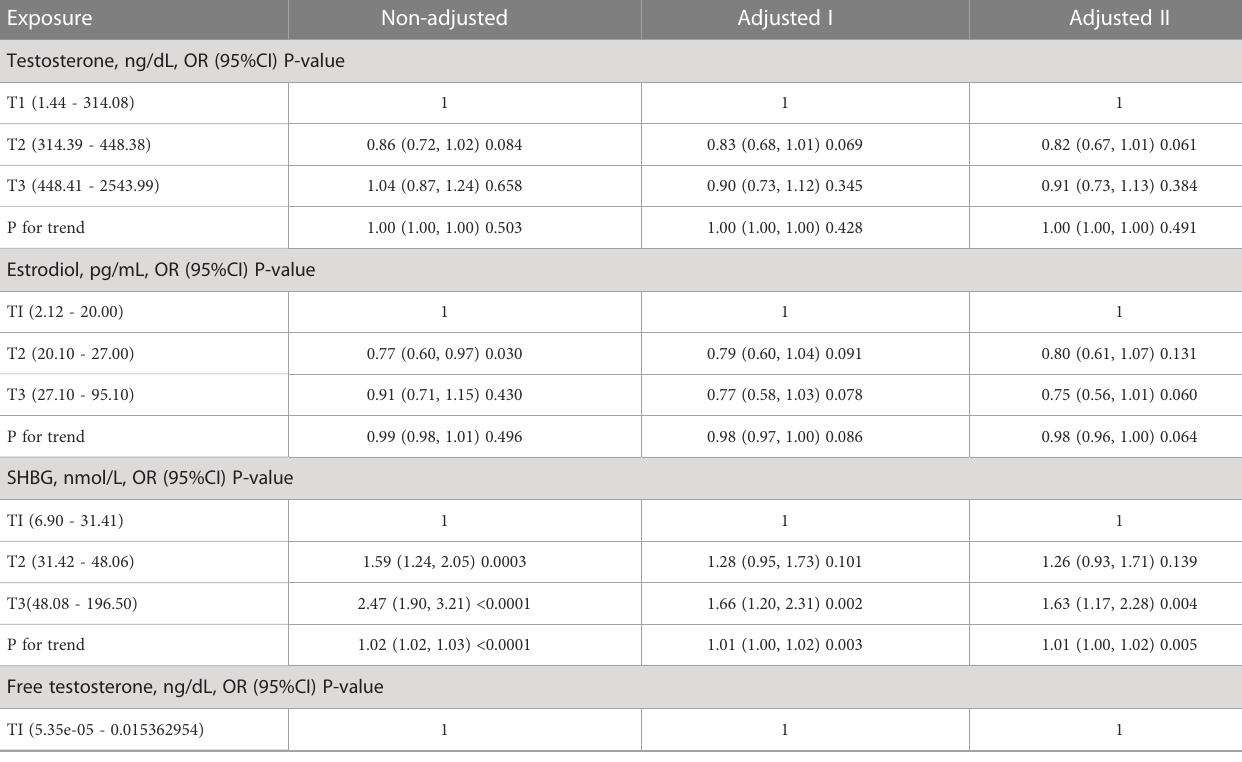
TABLE 2 The association of sex hormone levels sorted by tertile with periodontitis in males. . Exposure